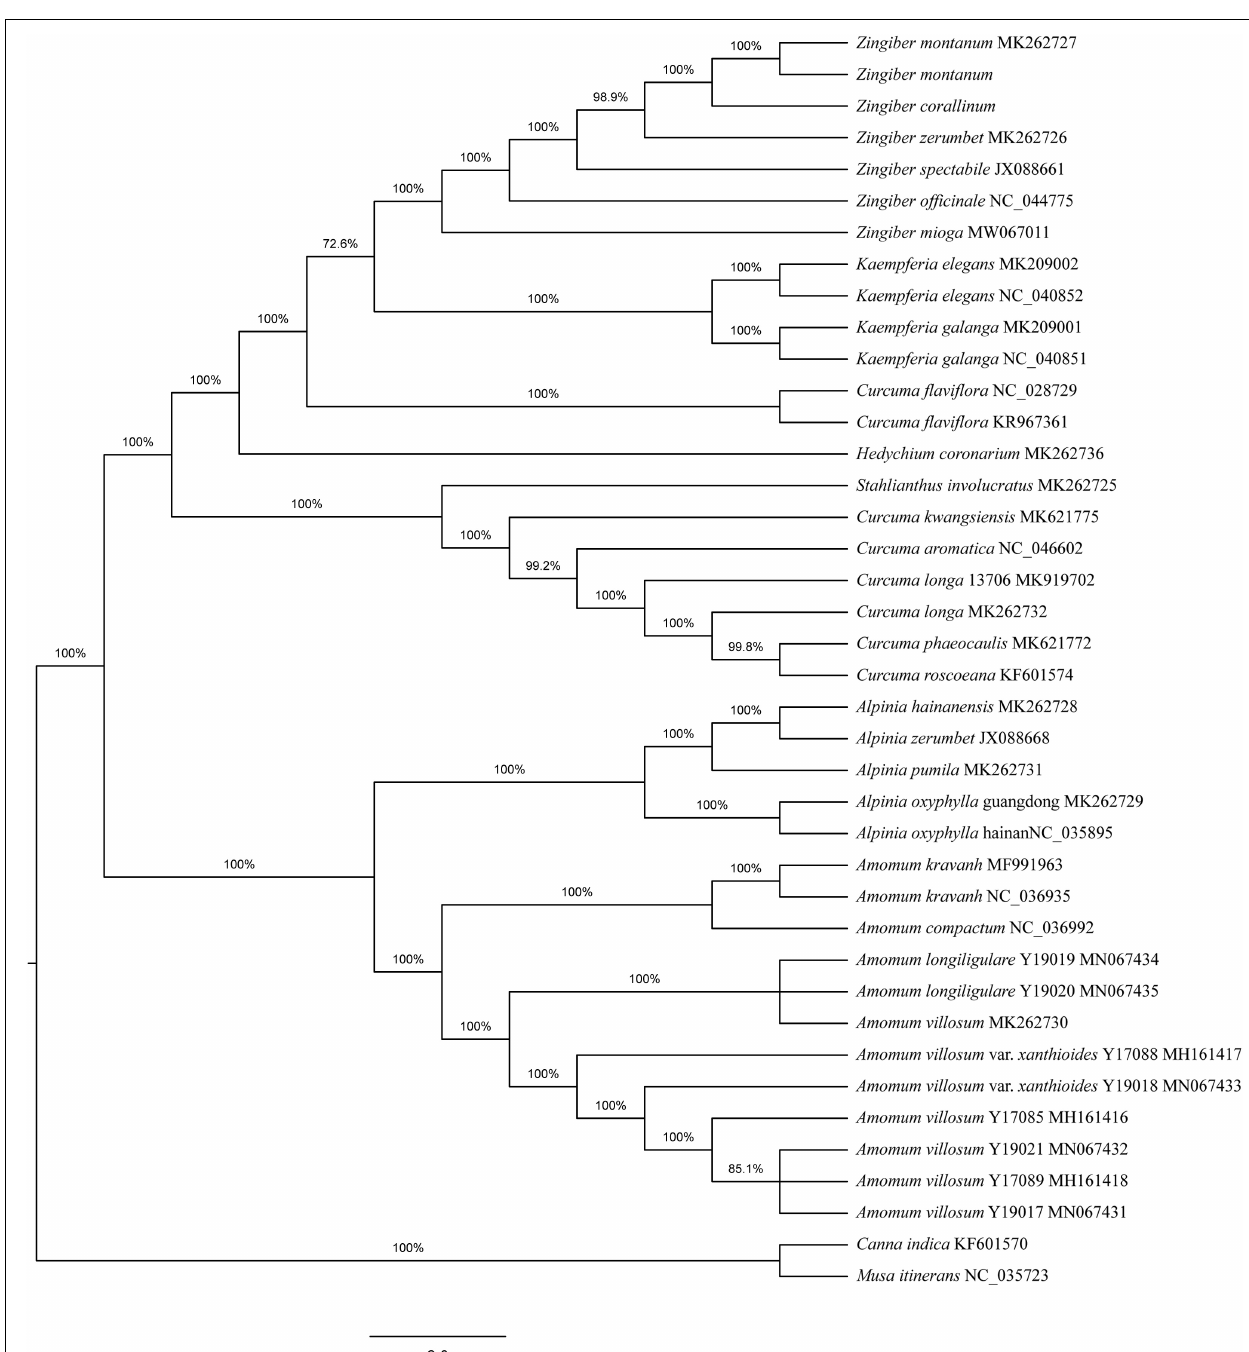
FIGURE 3 | Phylogenetic tree constructed using Neighbor-Joining (NJ) based on complete cp genomes of 36 Zingiberaceae species. Numbers above the branches are the bootstrap support values.